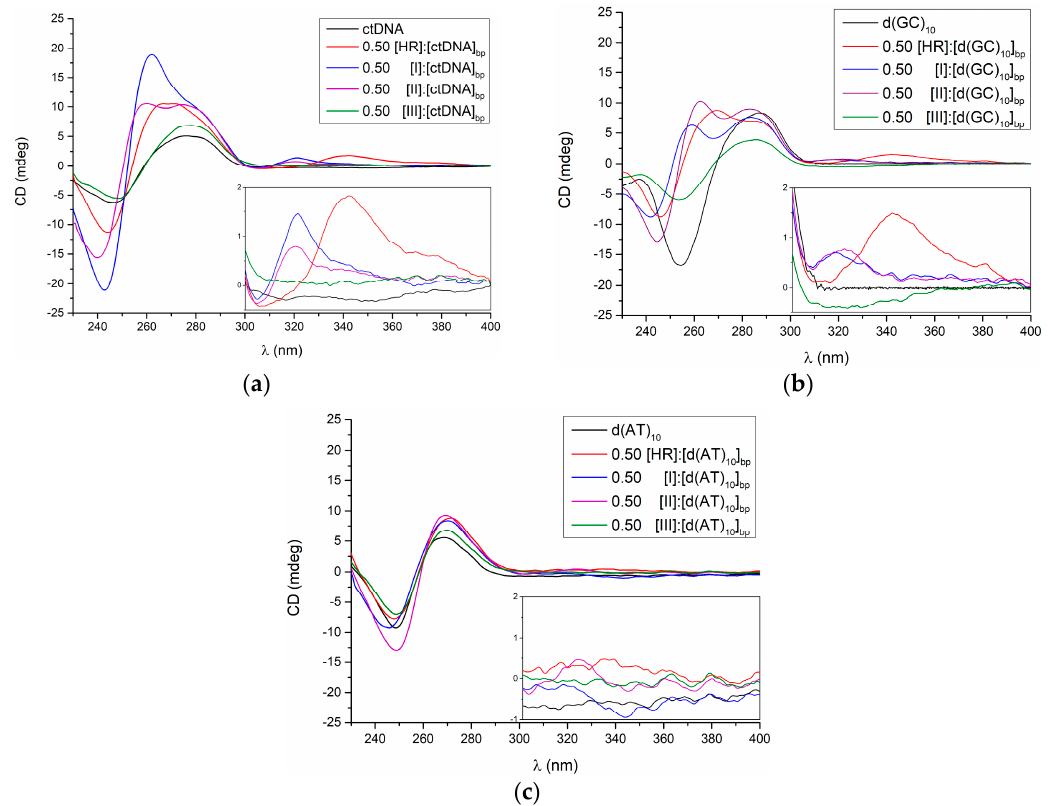
Figure 5. Circular dichroism spectra of ( a ) ctDNA; ( b ) d(GC) 10 ; and ( c ) d(AT) 10 , either free or as bound at 0.50 [ligand]:[DNA] bp ratio to the harmine or its three derivatives.